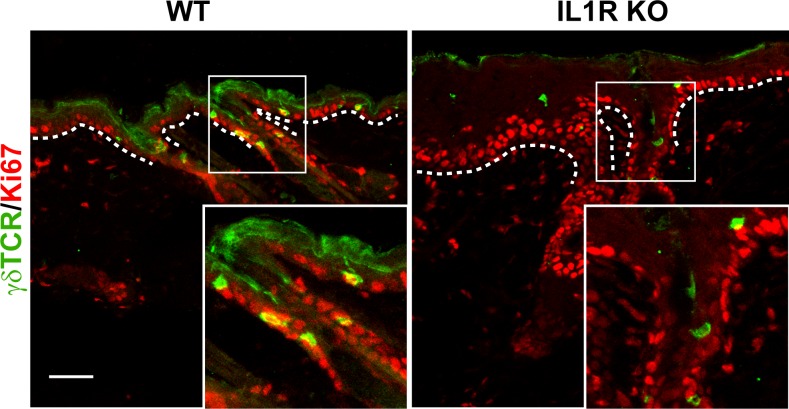
Proliferation of γδT-cells post wounding.Skin sections from 8-week-old wild-type (WT) or IL1R KO mice were stained for γδT-cells (green) and Ki67 (red) 3 days post wounding. Boxed regions are shown as magnified images in the insets. White dotted lines denote the basement membrane that separates the epidermis from the underlying dermis. Scale bar = 50 μm.